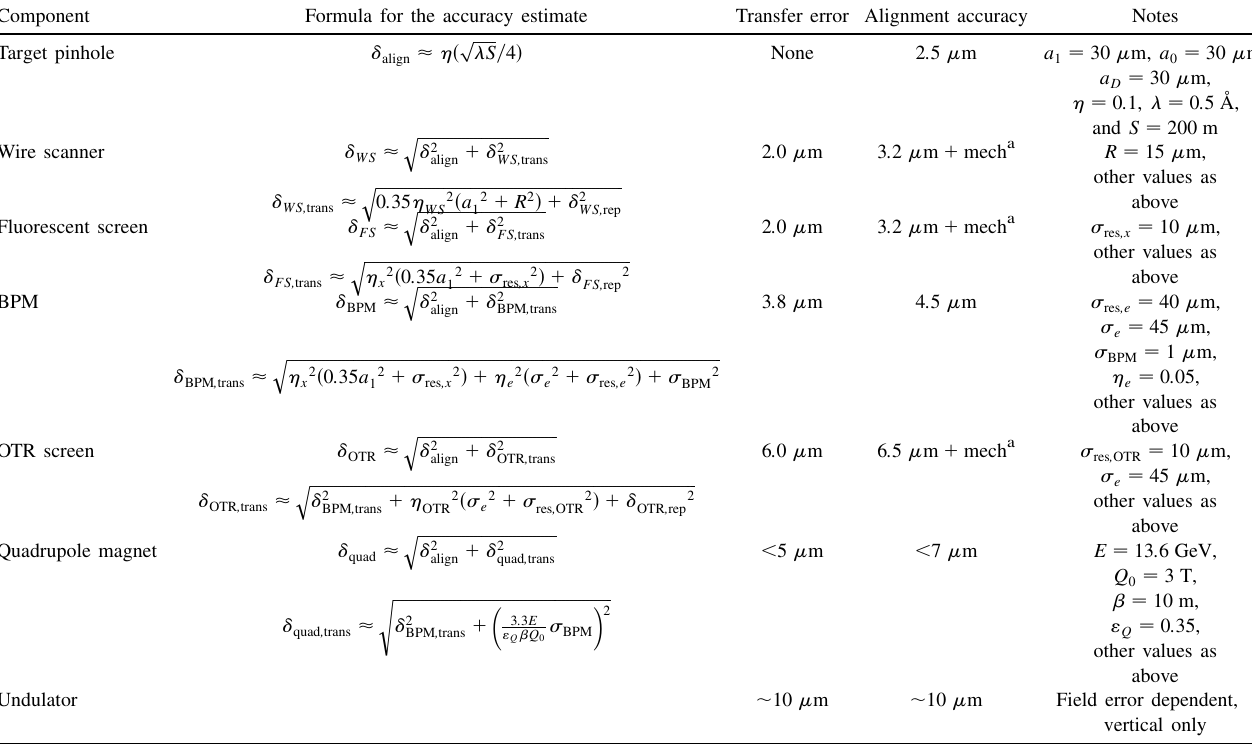
TABLE V. RMS XBBA accuracy for LCLS undulator